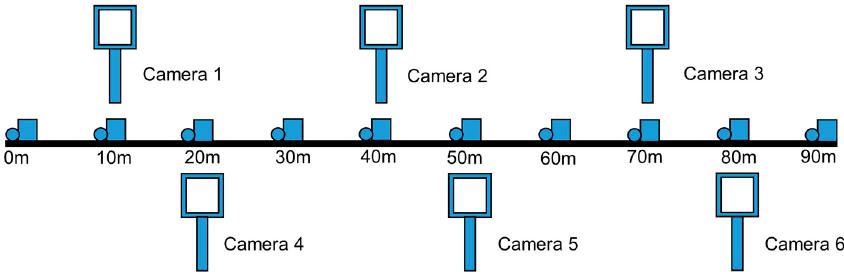
Figure 2. Multiple camera setup for each site on an East-West 100 m transect, camera field of view point towards the transect. Empty squares represent the cameras, while small blue circles and squares along the transect represent potential vegetation plot sites.